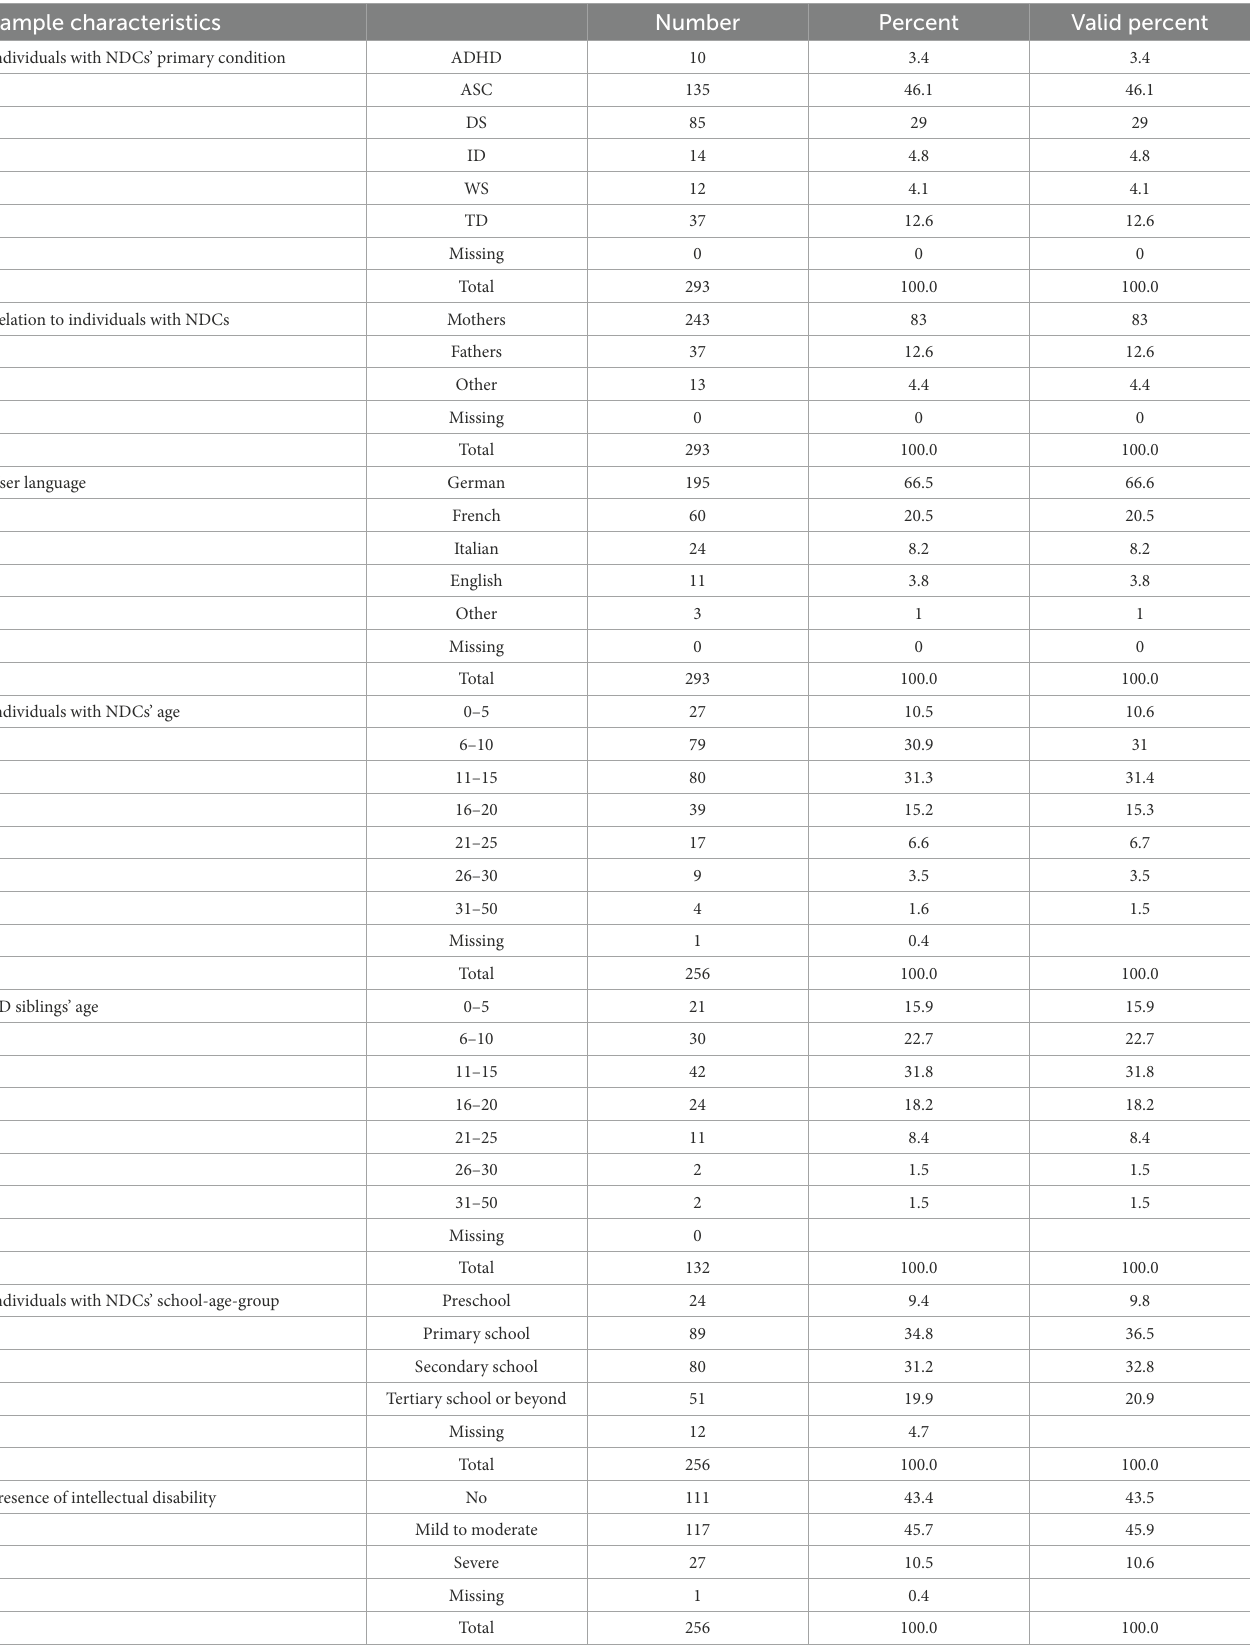
TABLE 3 Sociodemographic characteristics of the sample. Sample